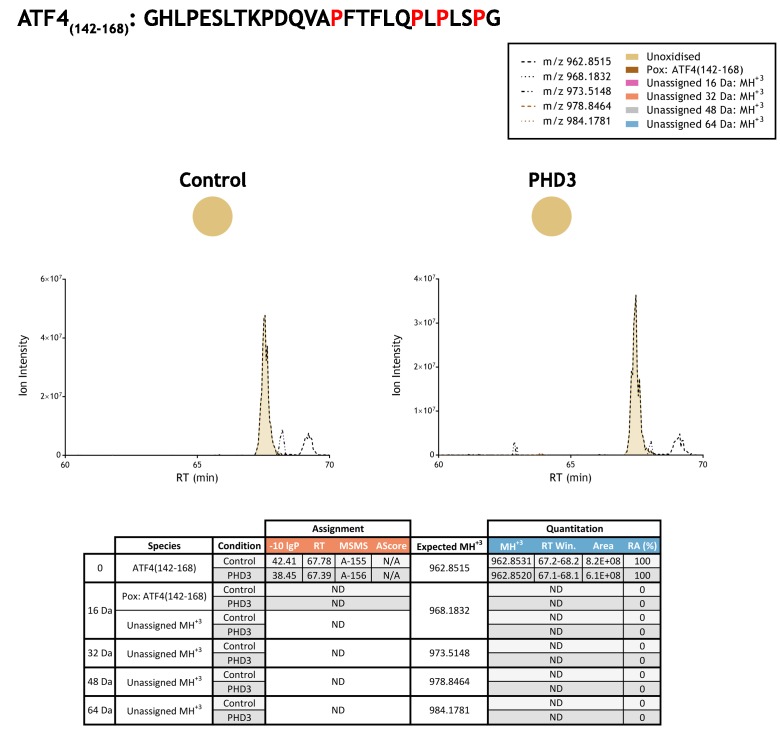
Quantitation of peptide oxidation on ATF4(142–168) following reaction of full-length activating transcription factor 4 with recombinant PHD3.Peptide LC-MSMS analysis of activating transcription factor four target residues (P156, P162, P164, P167) required digestion with a broad specificity protease (elastase); XIC data correspond to abundant fragment ions and are representative of an overlapping series of fragment ions containing one or more target proline residues. Note, hydroxyproline peptide standards were not employed owing to the number of target proline residues in ATF4 (five candidate proline sites were defined between residues 156–174), which would require an extensive panel of peptide standards to represent all permutations (including multiple oxidations). XIC data for elastase-digested IVTT substrate under control (left) or PHD3-reacted (right) conditions. Peaks corresponding to unoxidised ATF4(142–168) were assigned by MSMS; proline oxidation was not detected on this peptide (or related peptides). Note, unshaded peaks (at RT:~69 min) corresponding to m/z 962.8515 and m/z 973.5148 are unrelated ions based on isotopic profiles (different monoisotopic mass and/or charge) observed in LC-MS data. Unassigned ions of compatible mass over charge for hydroxylation were not observed across the elution window; up to four oxidations commensurate with the number of target prolines in the ATF4(142–168) peptide were considered (see inset). Quantitative data for observed species are presented as pie charts with XIC data. Assignment and quantitation data are tabulated below, table headers are as follows: (−10lgP) significance score of leading assignment at given (RT) with ambiguity score (AScore) for PTM localisation and reference to primary MSMS data in Supplementary file 1. Quantitative data reports ion counts (Area) of observed masses (MH+3) integrated over time (RT Win.), expressed as relative abundance (RA).